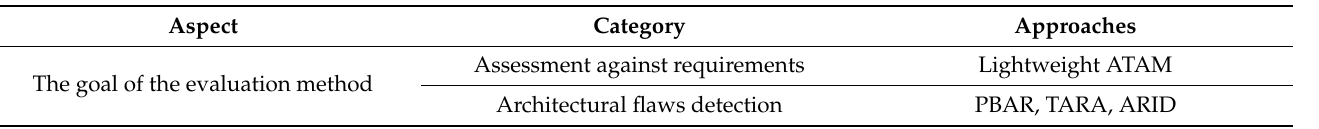
Table 5. Lightweight methods